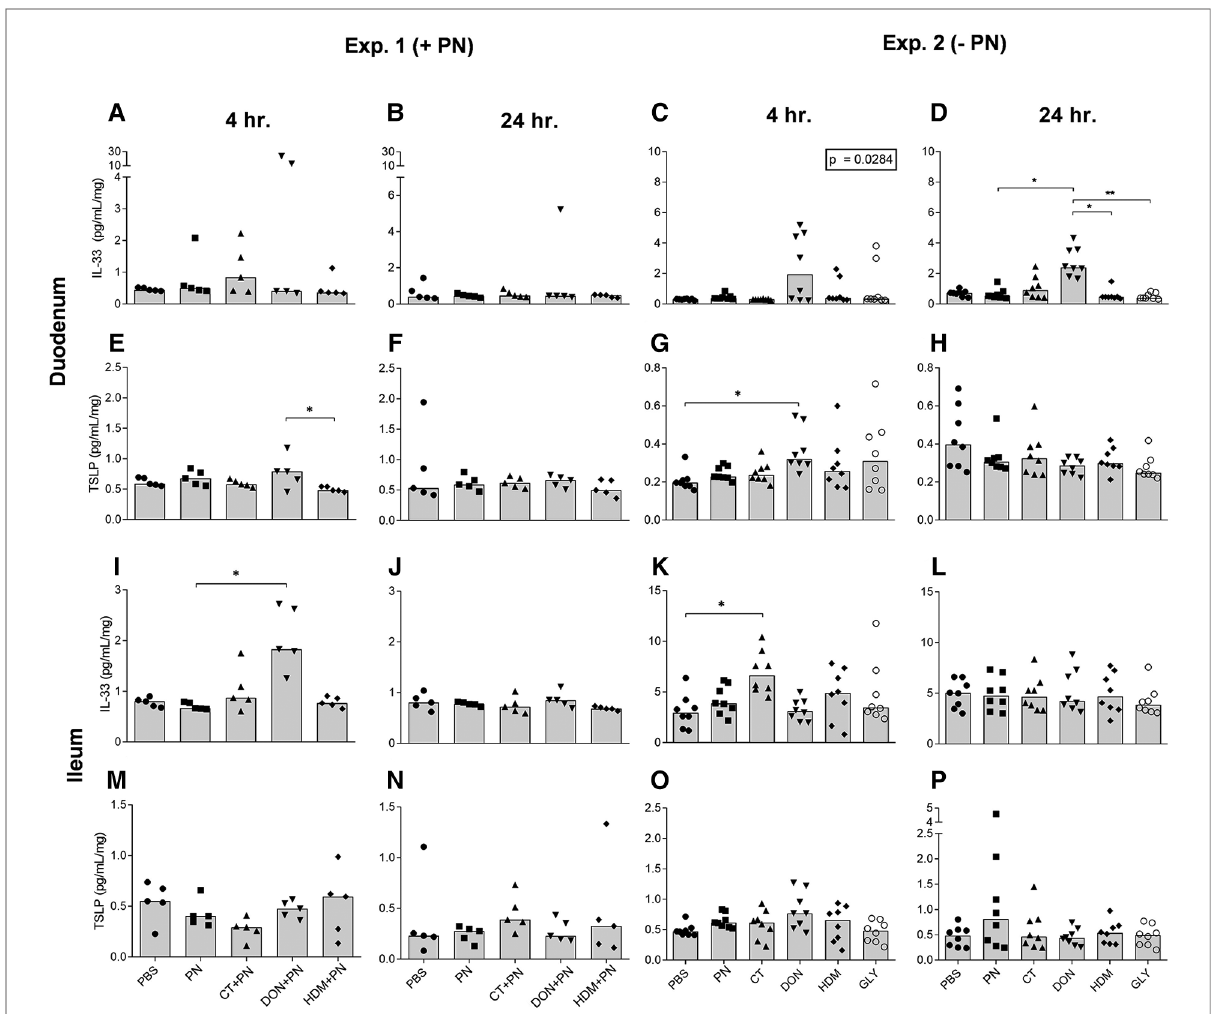
FIGURE 4 IL-33 and TSLP concentrations per mg tissue in duodenum and ileum after a single i.g. dose of PBS, PN or a barrier disruptor with (exp. 1, n = 5) or without (exp. 2, n = 8) PN. The fi gures show levels at 4 h (A, E, I, M ) and 24 h (B, F, J, N ) in exp. 1, and at 4 h ( C, G, K, O ) and 24 h ( D, H, L, P ) in exp. 2. ( A, B, C, D ) shows IL-33 and ( E, F, G, H ) shows TSLP in duodenum. ( I, J, K, L ) shows IL-33 and ( M, N, O, P ) shows TSLP in ileum. Brackets denote statistically signi fi cant differences (* p <0.05, ** p <0.001) between two groups. Columns denote the group median value while each symbol denotes the individual animals. Inserted box: p value for the Kruskal-Wallis